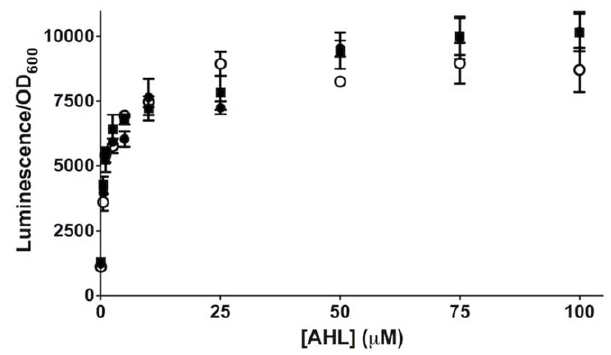
Figure 5. Autoinducer activities of AHLs 3a and 3b in comparison to AHL 1 in P.aeruginosa strain PAO-JP2. Values shown are relative luminescence units normalized with respect to cell viability (OD 600 ). Closed square = 1 . Closed circle = 3a . Open circle = 3b